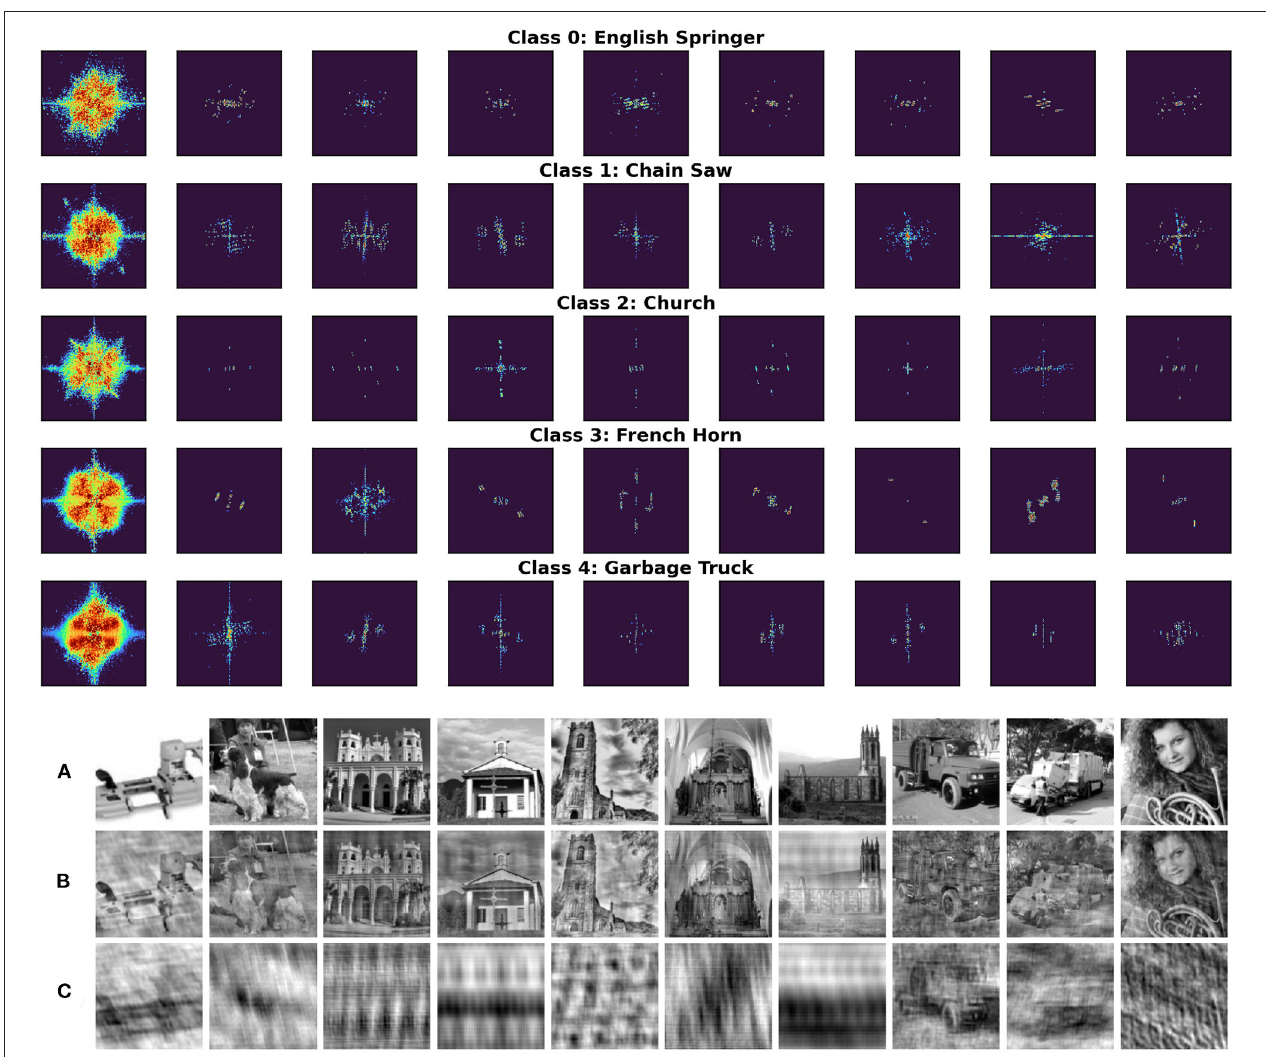
FIGURE 5 | (Top) Randomly sampled single image masks divided by class. The first column corresponds to masks trained on all the images belonging to each class separately. The colormap is the same as that of Figure 3 . (Bottom) (A) Randomly sampled images; (B) filtered by their complementary masks M c N , x ; (C) the same images filtered by their associated Fourier masks M N , x